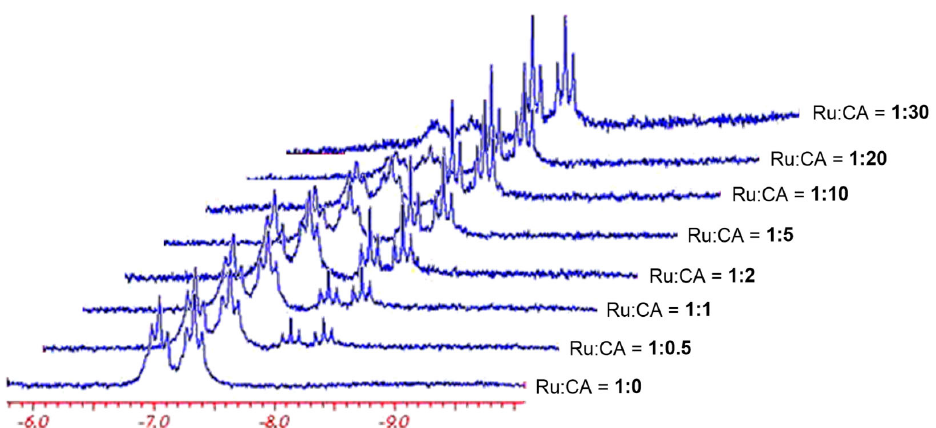
Figure 11. Effect of increasing amounts of cinnamaldehyde (CA) on the 1 H-NMR spectra (hydride region) of [RuHCl(CO)( m tppms-Na) 3 ] ( 1 ) solutions under argon at various [Ru]/[CA] ratios. Condi- tions: n( 1 ) = 0.015 mmol, T = 298 K, 0.6 mL solvent (H 2 O/CD 3 OD = 50/50 V/V).